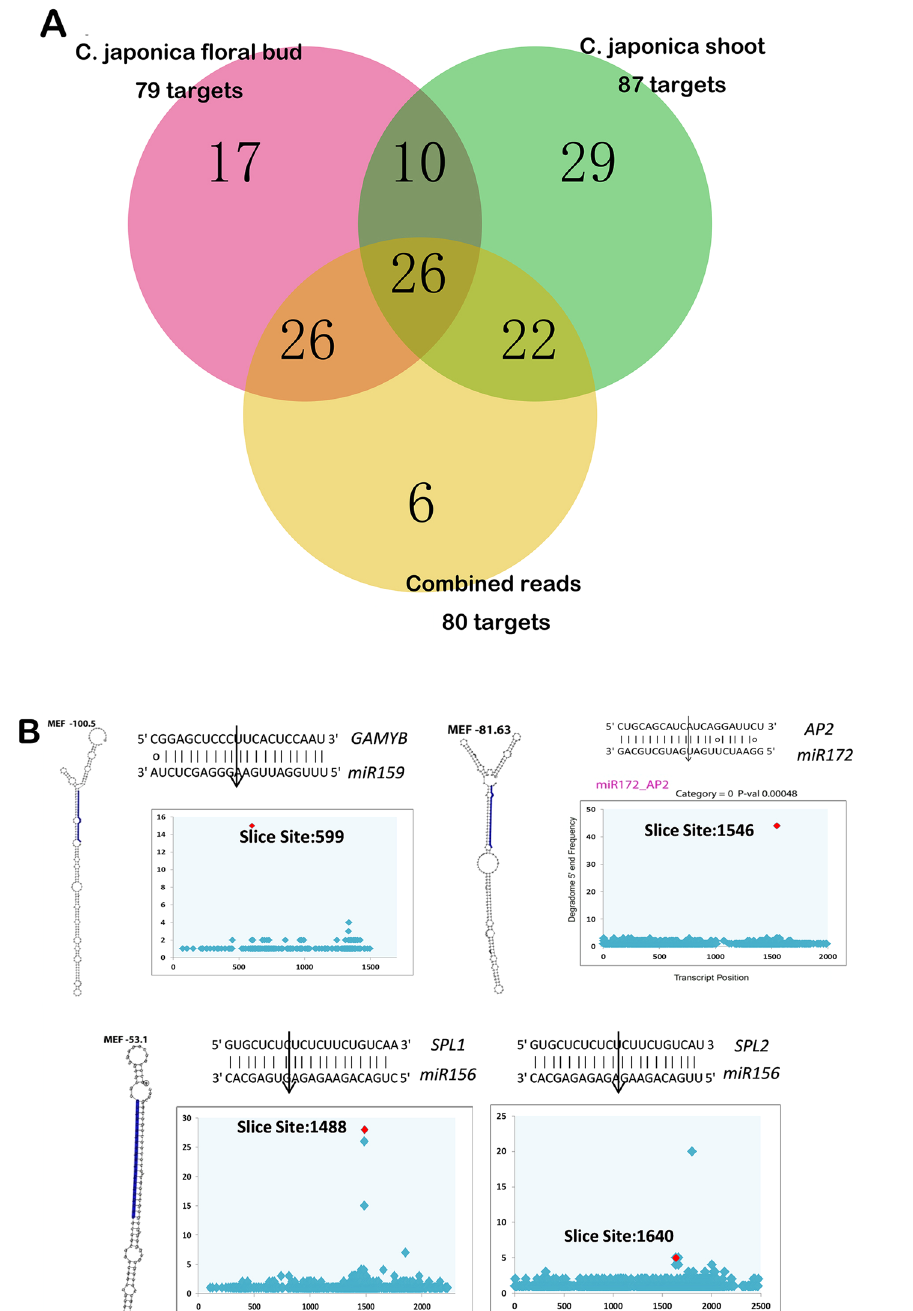
Figure 5. Analysis of miRNA-Targets from small RNA and degradome sequencing. ( A ) The venn plot of highly confident miRNA targets from degradome sequencing. The degradome libraries of shoot and floral bud were analyzed independently and also merged together to identify targets. ( B ), in each panel, left displayed the secondary structure of miRNA precursors and blue color highlighted the mature miRNA sequences. Right, the T-plot of key miRNA targeted slicing sites validated in the degradome sequencing. The slicing sites were indicated by